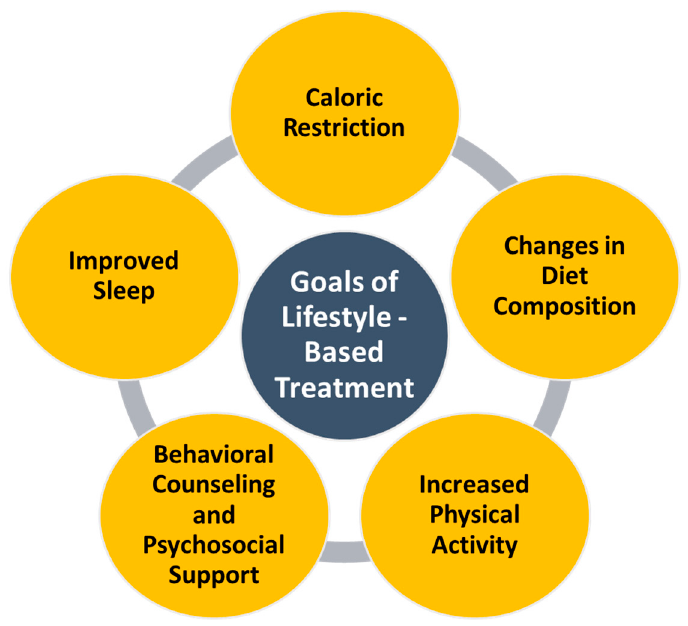
Figure 1. Goals of Lifestyle-Based Treatment.